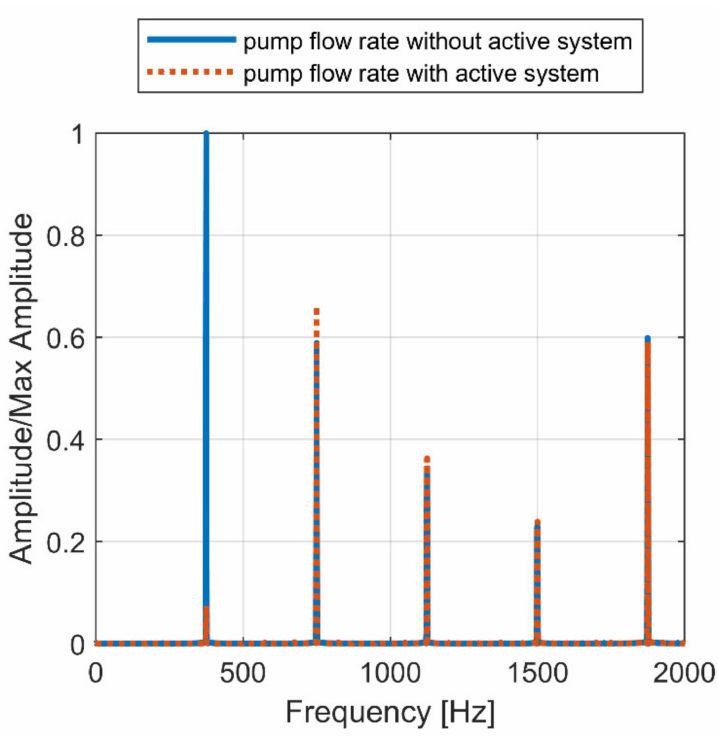
Figure 24. Simulation cycle 1, section 3: flow ripple FFT at 30 bar, 2500 rpm, 50% swash plate inclination.